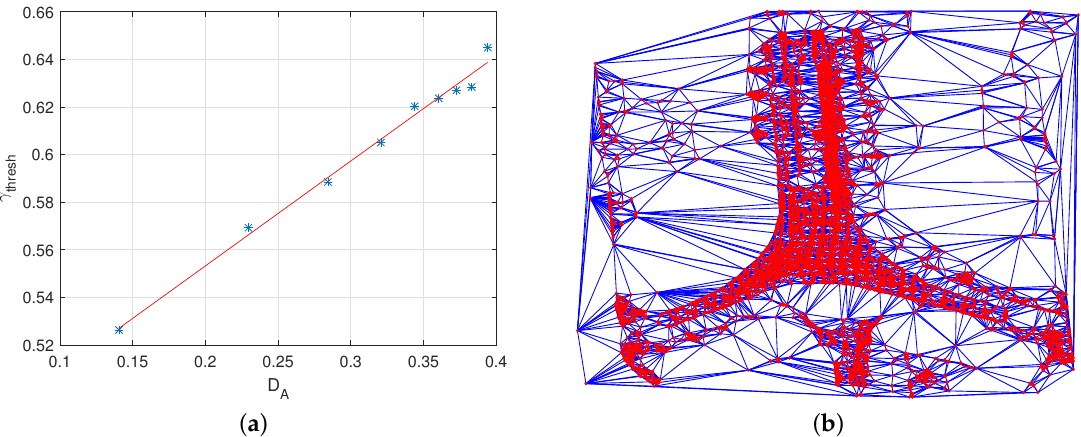
Figure 6. PS selection processes of Step 2 and 3: ( a ) the linearly fitted model between spatial coherence threshold and D A ; and ( b ) the Delaunay triangulation network of the updated